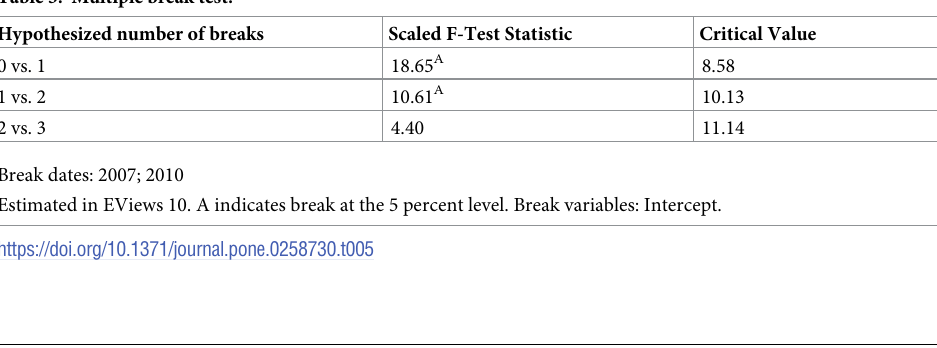
Table 5. Multiple break